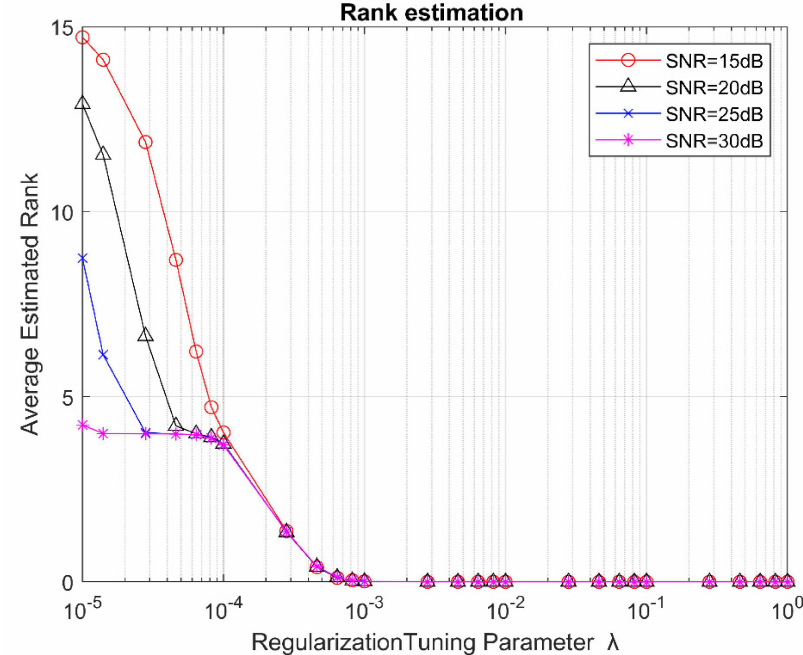
Figure 2. Rank estimation performance of the l 1 Regularization LS method as a function of λ with real rank R = 4.